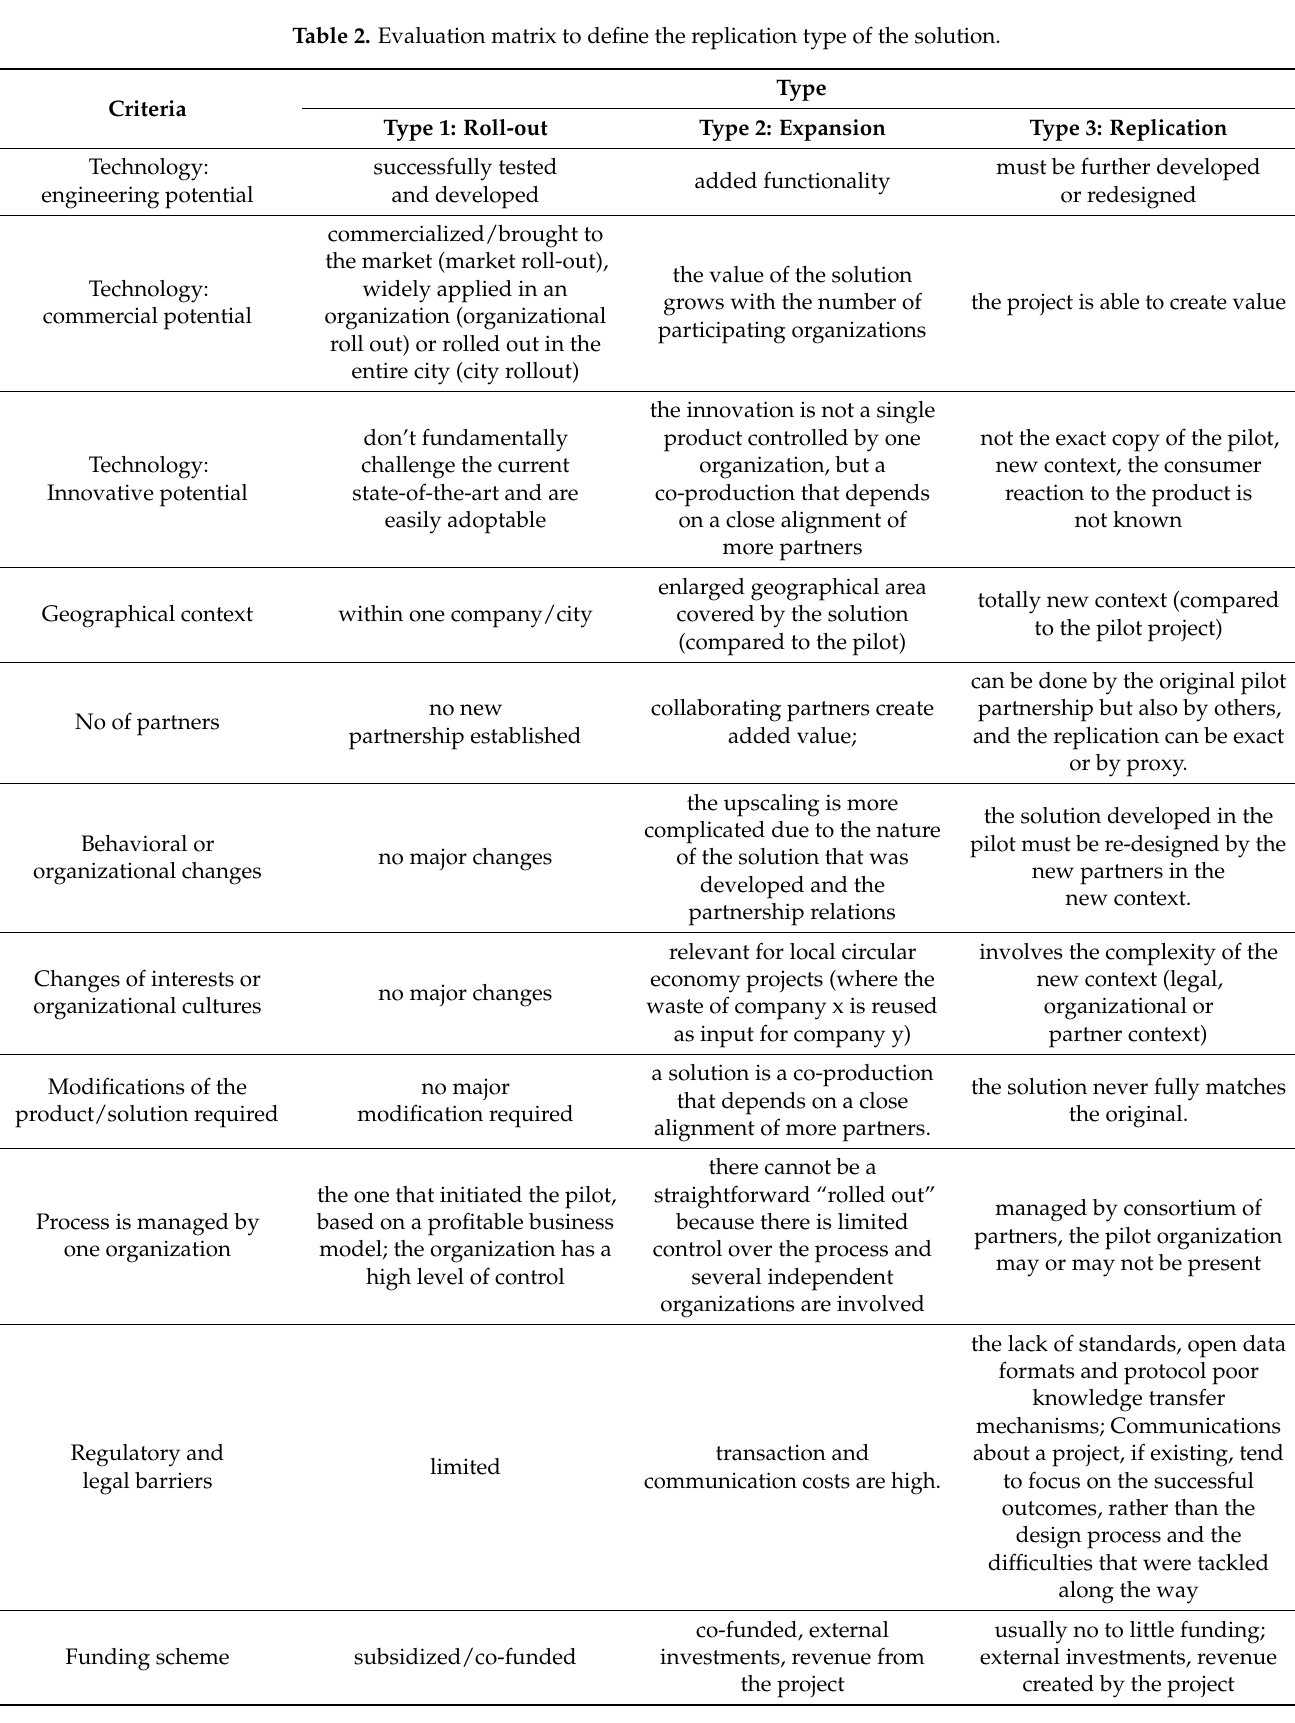
Table 2. Evaluation matrix to define the replication type of the